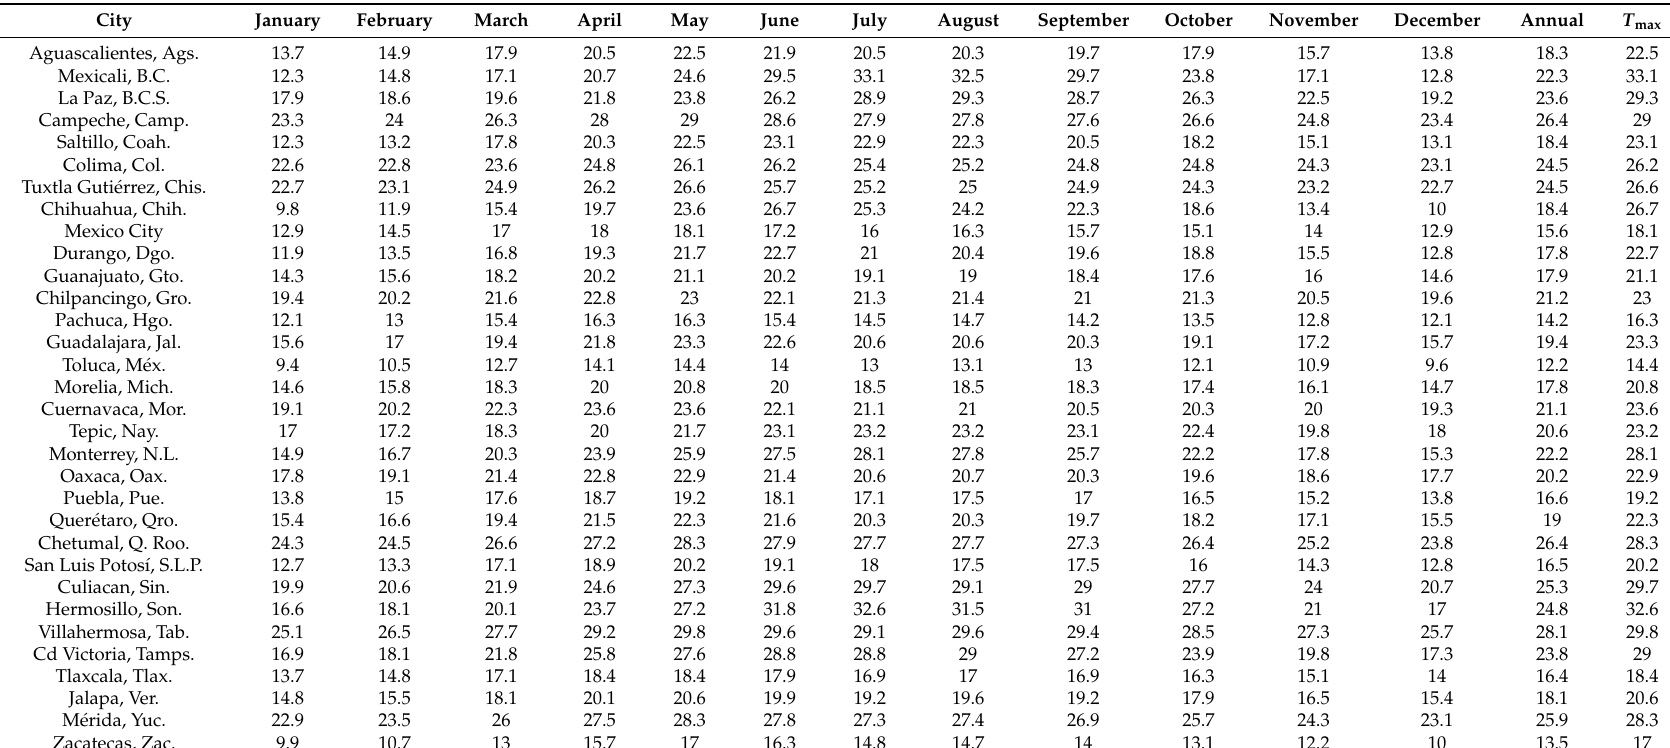
Table 1. Monthly mean temperatures for state capital cities in Mexico ( ◦ C). SMN 1951–1980